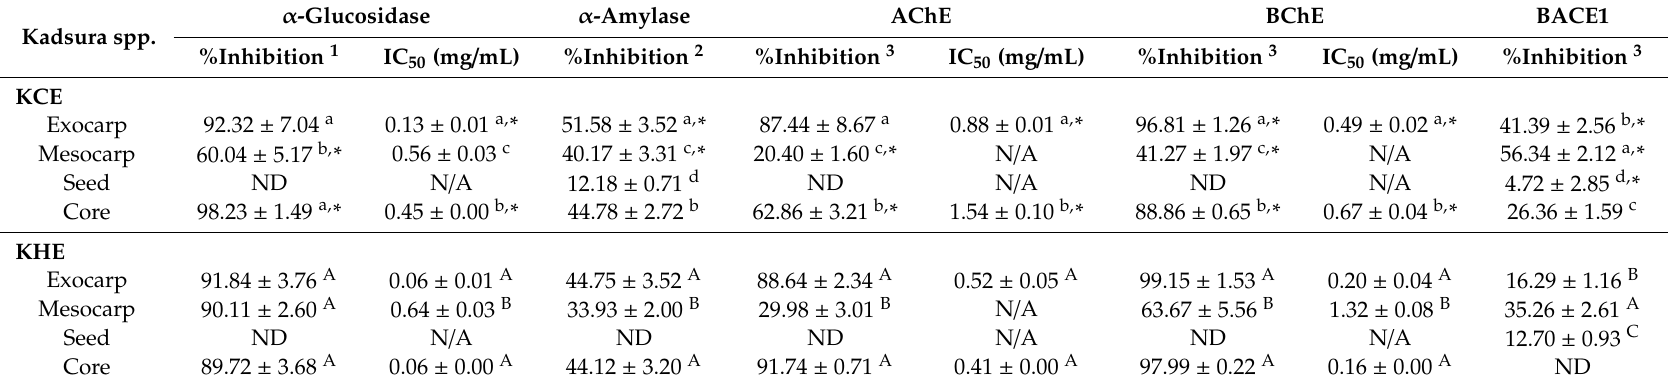
Table 6. In vitro enzyme inhibitory activities in di ff erent fruit parts of Kadsura coccinea (Lem.) A.C. Sm. extract (KCE) and Kadsura heteroclita (Roxb.) Craib extract